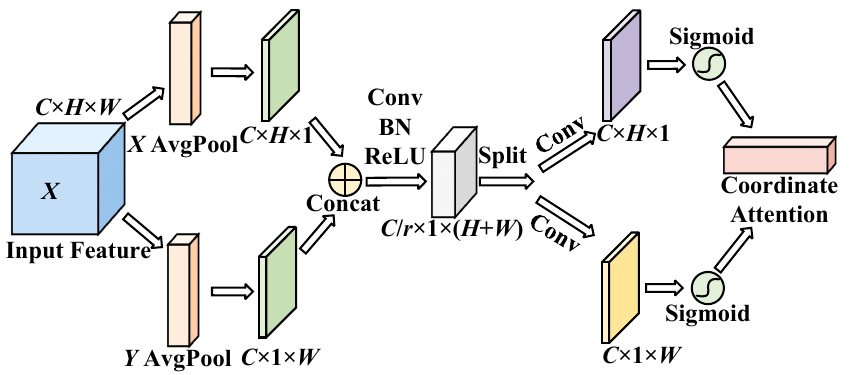
Figure 4. Architecture of the CAM.